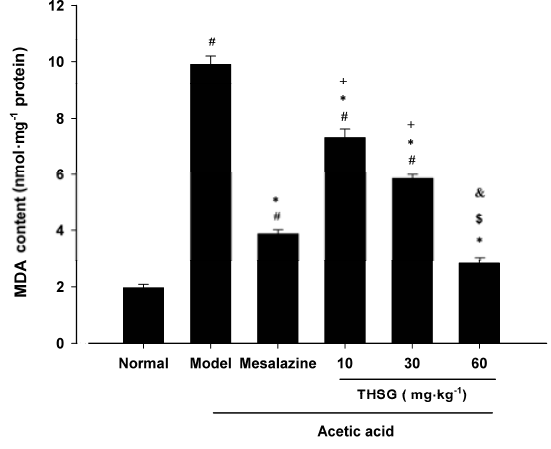
Figure 4. Effect of THSG on MDA content in colonic tissues of mice treated with acetic acid. Values are means ± SEM (n = 12 for each group). # p < 0.05 versus Normal group; * p < 0.05 versus Model group; + p < 0.05 versus Mesalazine group; $ p < 0.05 versus THSG 10 group; & p < 0.05 versus THSG 30